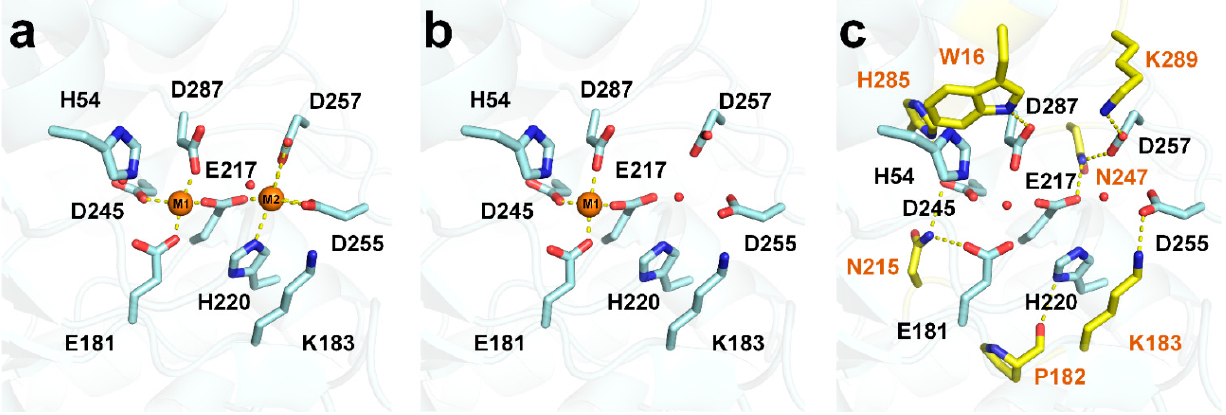
Figure 5. Three different metal ‐ binding states in the active site of the GI from Streptomyces rubiginosus (SruGI). ( a ) Two ‐ metal ‐ binding mode (PDB code: 6IRK), ( b ) one ‐ metal ‐ binding mode (PDB code: 5Y4I), and ( c ) metal ‐ free state of SruGI (PDB code: 7CJP).